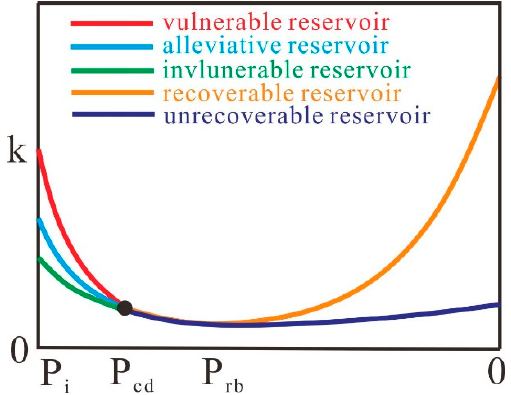
Figure 5. Sketch graph of the coal reservoir classification method.